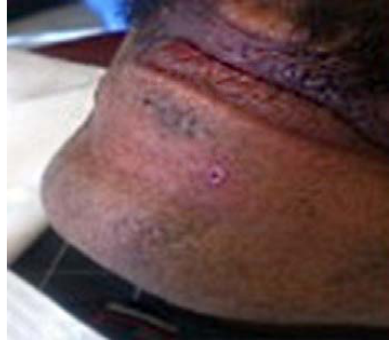
Figure 4. Pri-apical X-ray.